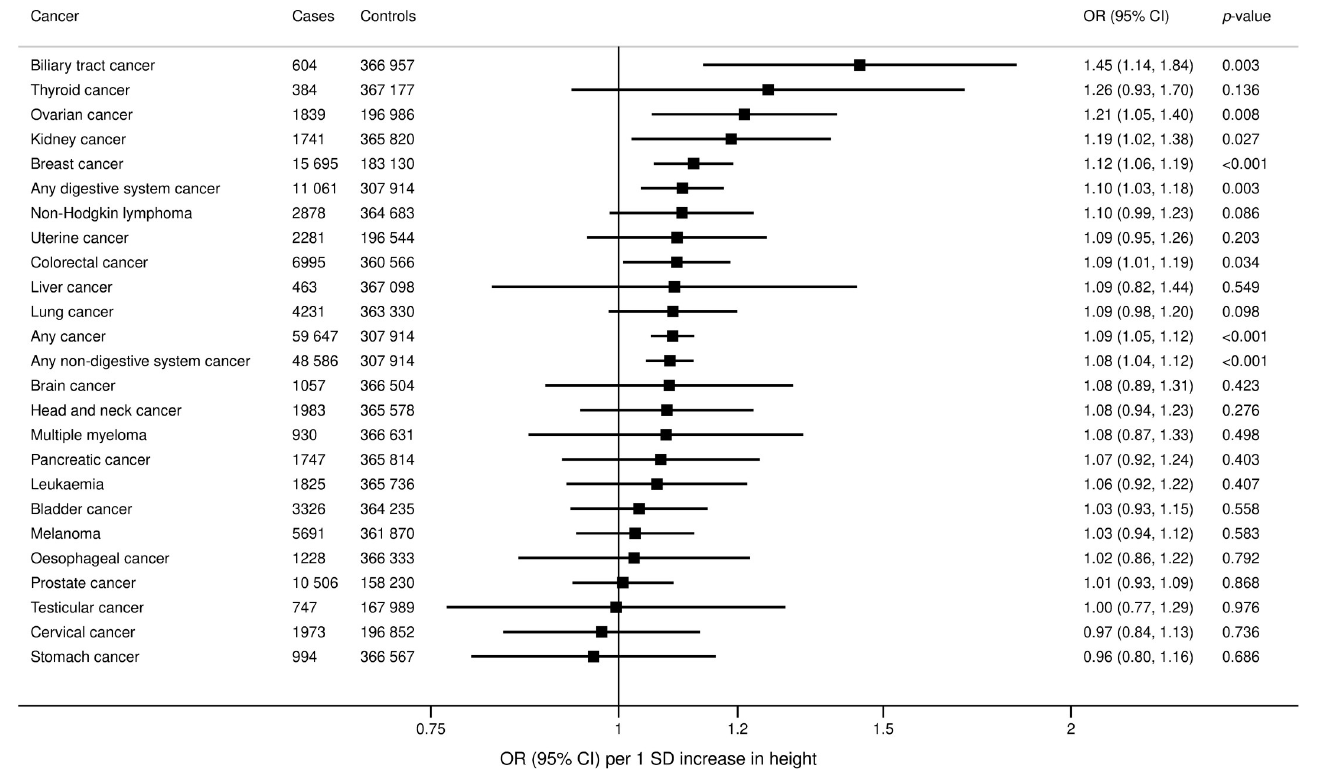
Fig 5. Associations of genetically predicted height with overall and site-specific cancers in the UKBB. ORs are expressed per 1 standard deviation (6.5 cm) increase in height. Results are obtained from the random-effects inverse-variance weighted method. CI, confidence interval; OR, odds ratio; UKBB, UK Biobank.